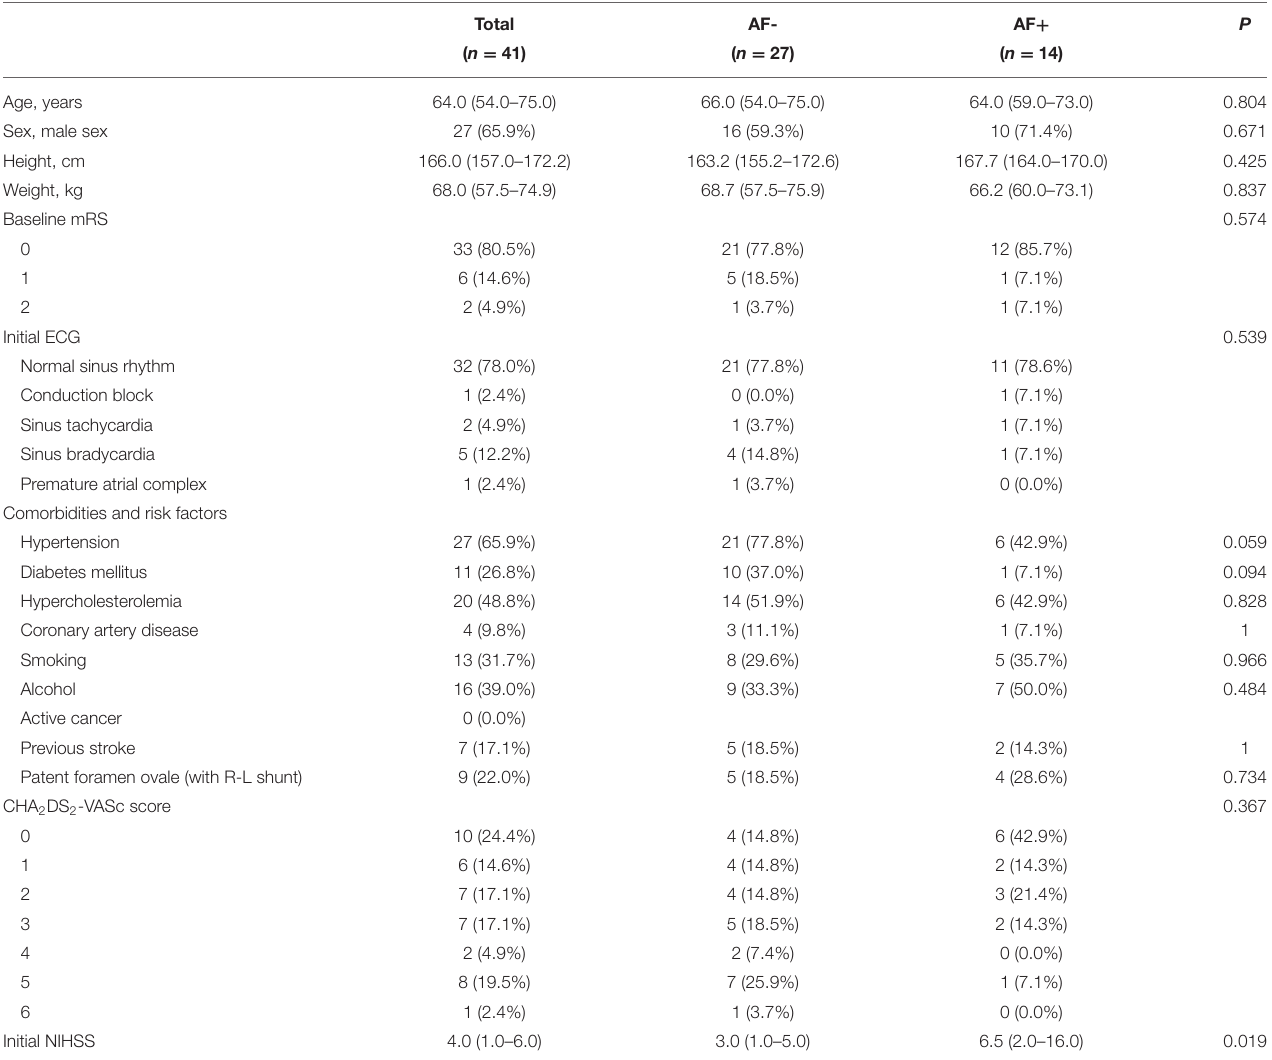
TABLE 1 | Baseline